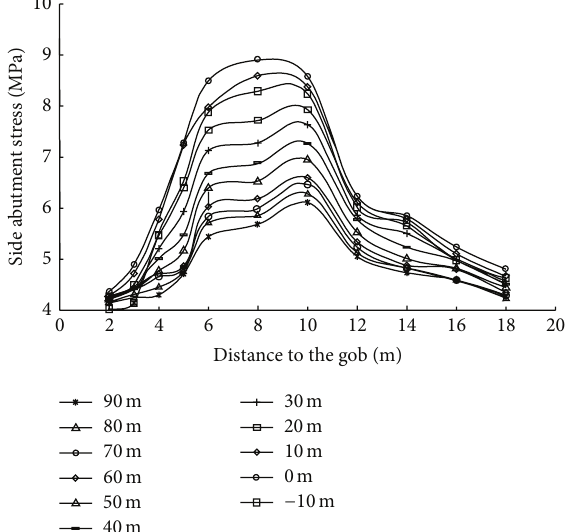
Figure 3: Measured curve of the distribution of the side abutment stress in Qianyingzi mine. In the figure: −10 m , 0 m , 10 m ,...,90 m representsthehorizontal distance oftheborehole stress-meterto the gob, respectively; the initial pressure of the borehole stress-meter is 4.0 MPa.